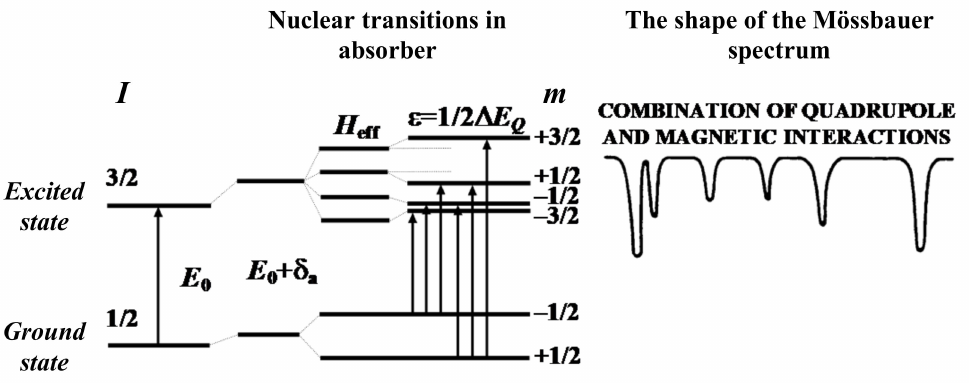
Figure A8. Scheme of combination of the nuclear electric monopole and quadrupole interactions and dipole magnetic interaction, isomer shift δ , quadrupole shift ε = 1/2 ∆ E Q and magnetic hyperfine field H eff for the 57 Fe, resonance transitions and resulting shape of the Mössbauer spectrum. I is a nuclear spin, m is a magnetic quantum